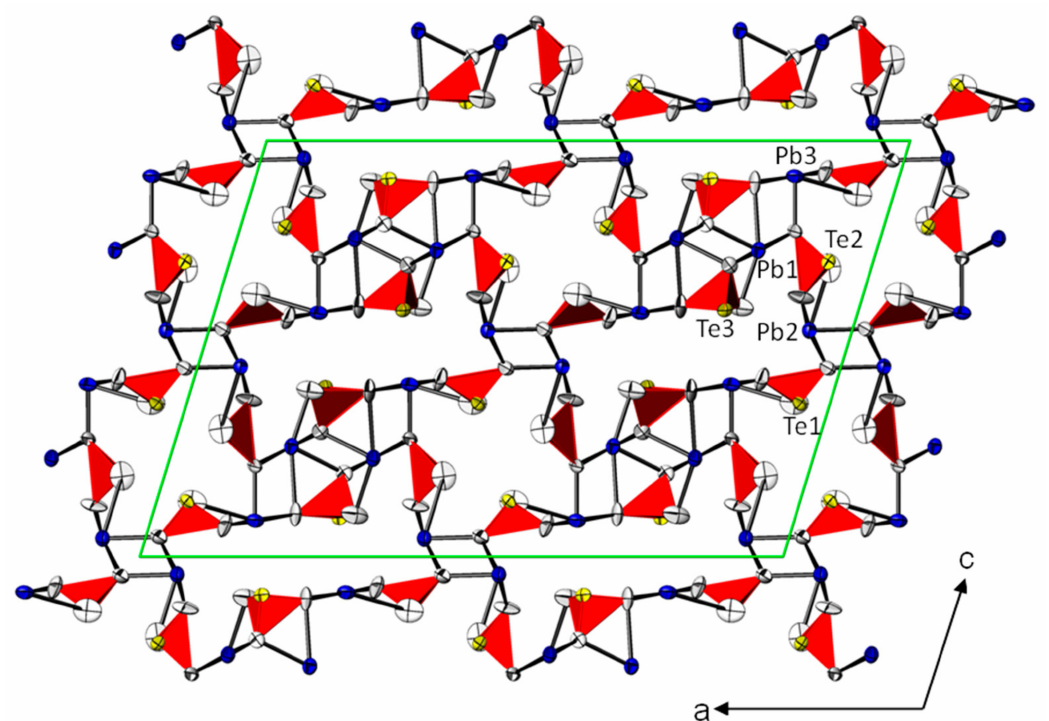
Figure 4. The crystal structure of α -PbTeO 3 in a projection along [010]. Colour codes and displacement ellipsoids are as in Figure 2. Crystal data were taken from the literature